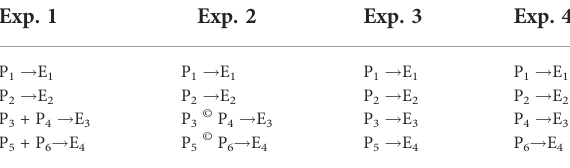
TABLE 8 Possible ways of the coupling DDL unit with the DSA unit.